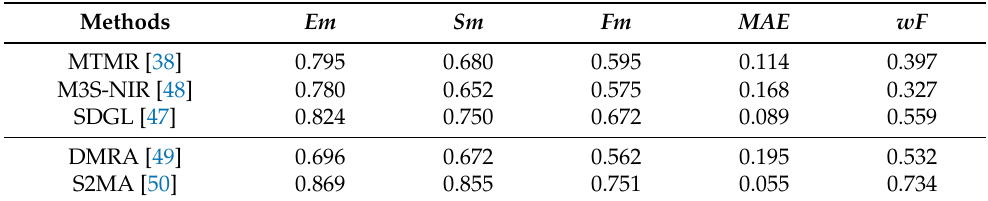
Table 8. The comparisons to the state-of-the-art methods on VT5000 RGBT SOD dateset. Our proposed AMFuse methods are with different ResNet backbone encoders, such as ResNet-18, ResNet- 50 and ResNet-152. * denotes adding a 1 × 1 convolution layer for the multiplication operation in the AMFuse++